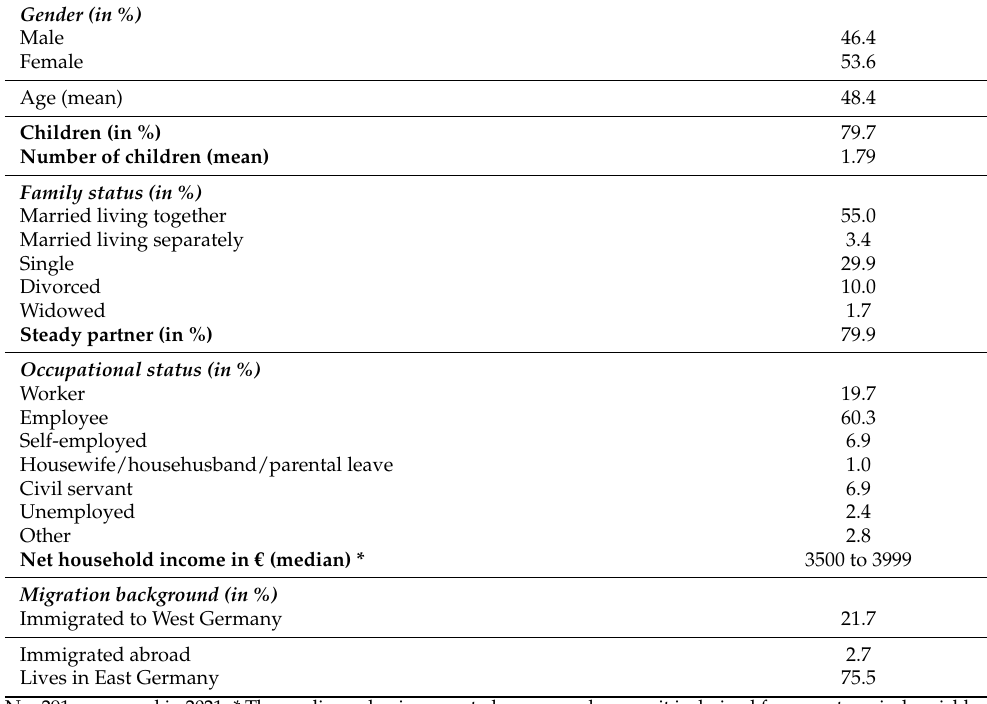
Table A1. Socio-demographic characteristics of the sample (measured in 2021).